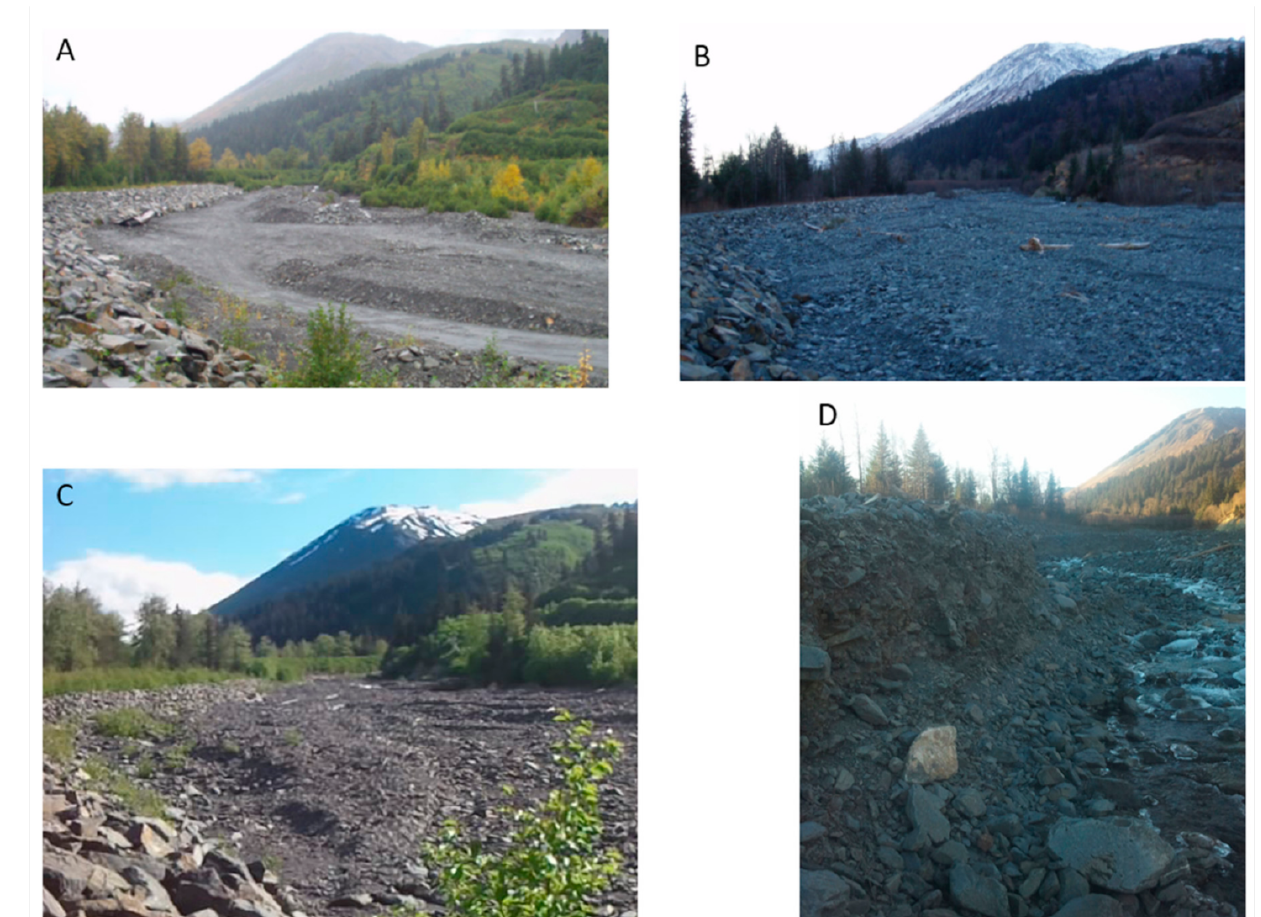
Figure 4. Photos taken at the boundary of reaches 2 and 3, looking upstream of the Japanese Creek Reserved stream corridor taken before and after to the severe storms of October 2006 and September 2012. ( A ) Photo taken just prior to the 2006 storm. Note the rip-rap levee on left [34]; ( B ) photo taken just after a severe storm in October 2006 showing vast amounts of sedimentation [34]; ( C ) photo taken in 2011 shows sediment redistribution and erosion that occurred during a period of typical rainfall events between 2006 and 2011; ( D ) photo taken in 2012, showing the upper reaches experiencing more erosion than sedimentation, compared to the storm in 2006. Photos A and B are reproduced with permission from Northwest Hydraulic Consultants,